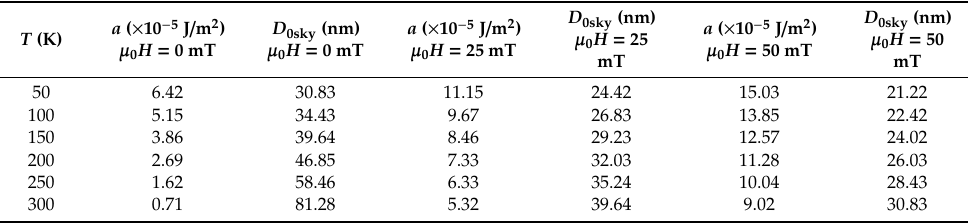
In Figure 2, the 2D skyrmion diameters distribution calculated via Equation (2) (solid black lines) is compared to the 3D distribution (dashed red lines) [13] obtained by means of Equation (1) for three different temperatures, T = 100 K, 200 K and 300 K, respectively and, at fixed T , for three values of the external bias field, μ 0 H ext = 0 mT, 25 mT and 50 mT, respectively.